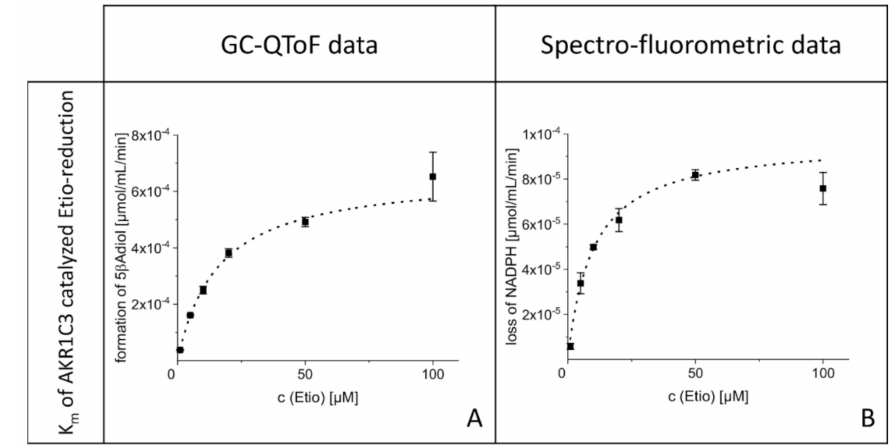
Figure 3. Michaelis-Menten curve of Etio with AKR1C3 generated with data from GC-QToF data ( A ): K m = 15.8 µ M (SE = 0.9 µ M) and spectro-fluorometric measurement ( B ): K m = 9.7 µ M (SE = 1.4 µ M).